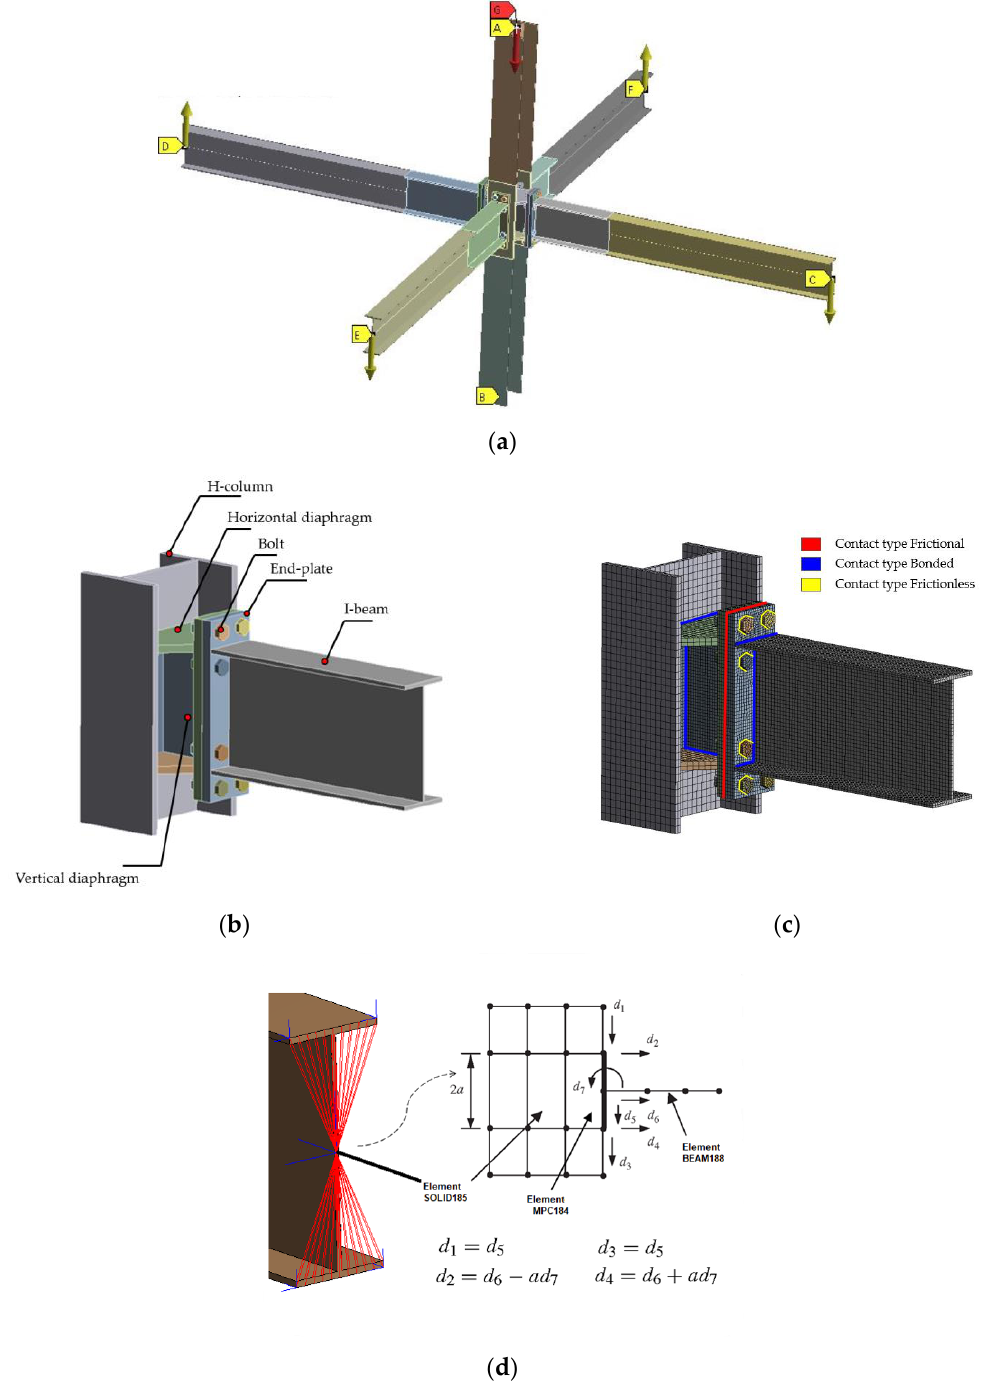
Figure 4. ( a ) Boundary conditions, ( b ) elements in moment connection, ( c ) contacts types in numerical model, ( d ) interface between frame element and solid elements.